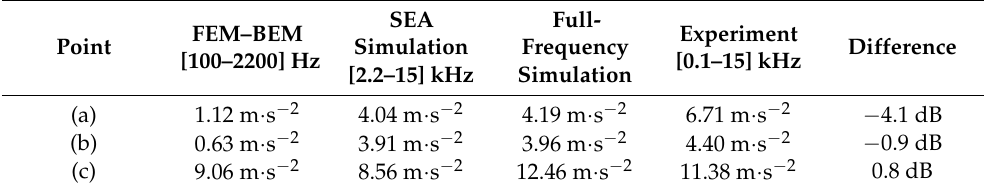
Table 3. Test–simulation comparison of the overall RMS level, in the [ 100 Hz, 15 kHz ] range, for the three locations